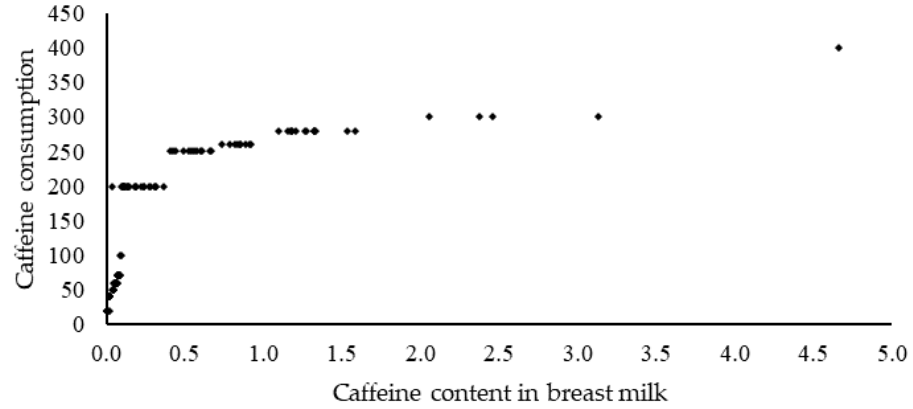
Figure 2. Correlation coefficients ( r ) calculated for the relationship between caffeine consumption and caffeine content inhuman milk (Correlation: r = 0.72). and caffeine content inhuman milk (Correlation: r = 0.72).